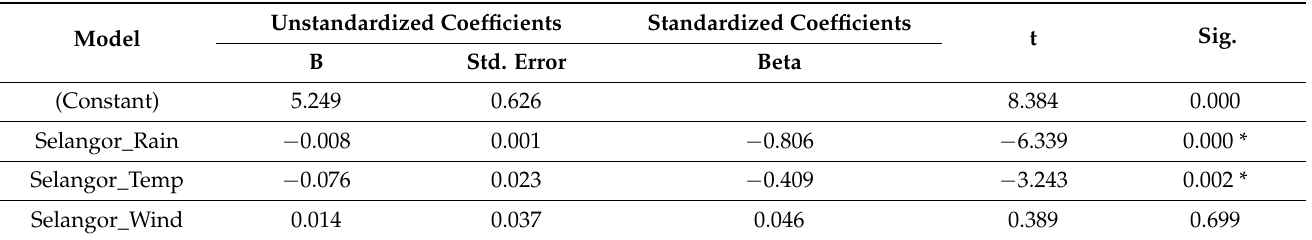
Table 4. Multivariate Linear Regression analysis between meteorological variables and dengue cases in Selangor,